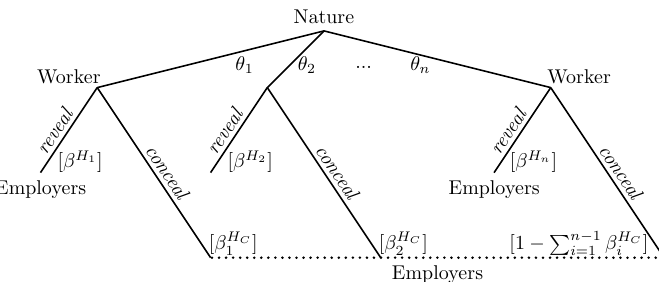
Figure 1. Initial stages of the revelation